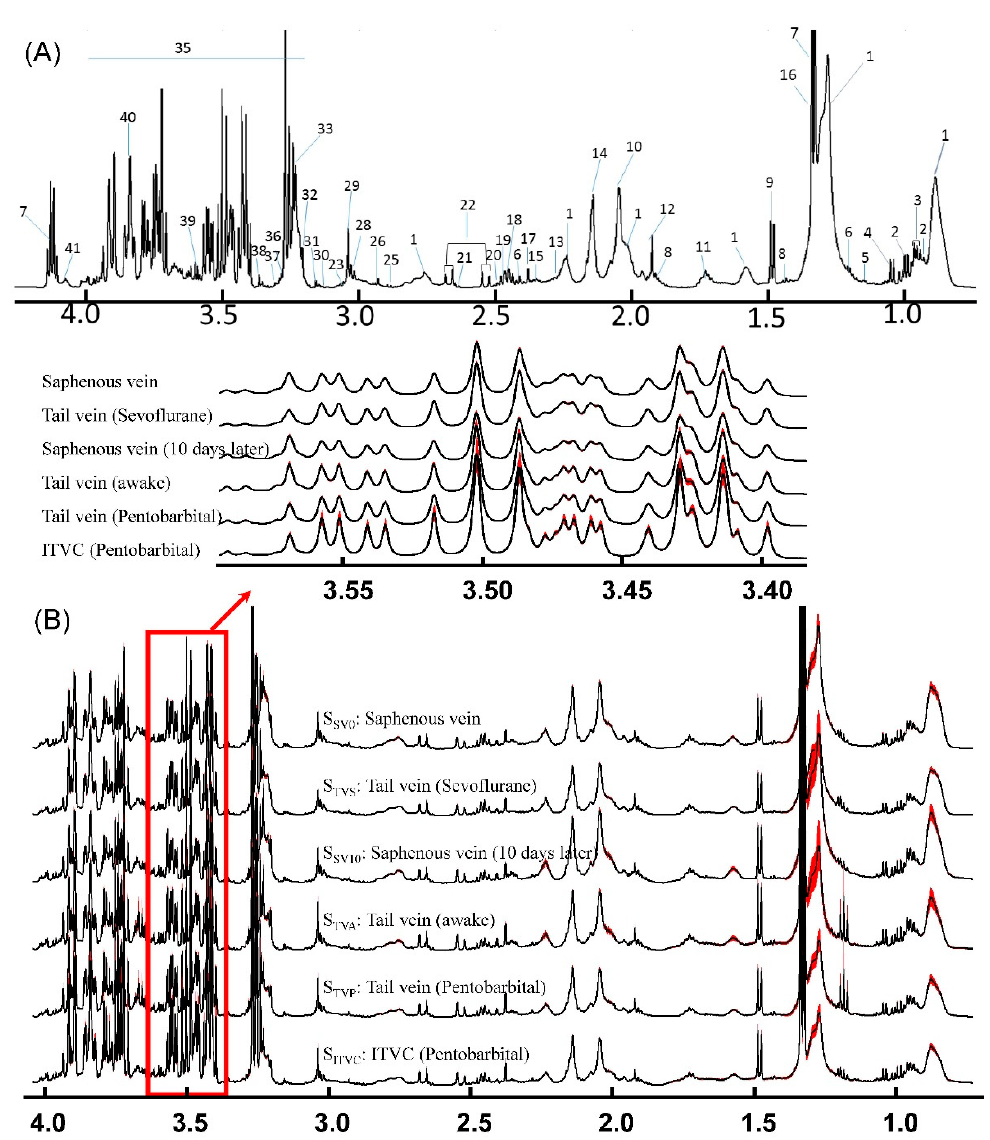
Figure 2. 1 H-NMR Spectra of blood samples. ( A ) Peak assignments of 1 H-NMR spectroscopy of one random blood sample; ( B ) Averaged 1 H-NMR spectra plus its’ SEM values point by point for various blood samples from different collection methods. Note: S: 1 H-NMR signals of various blood samples; Subscript: Please see Figure 1; Labels in Figure 2A are demonstrated in Table 2.